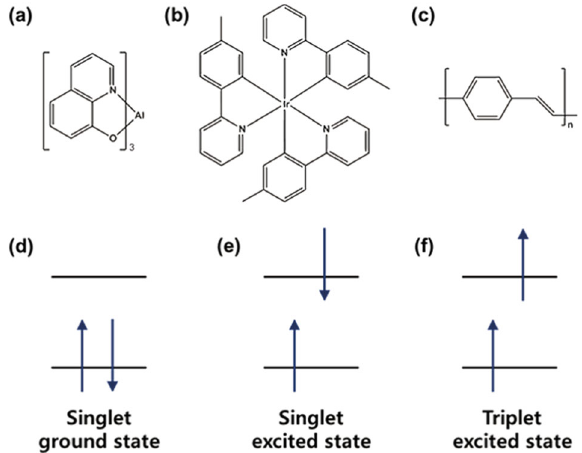
Fig. 7 Chemical structure of a Alq 3 fl uorescent dye, b Ir(mppy) 3 phosphorescent dopant, and c PPV used in OLEDs. d Illustration of electron spin in singlet ground state, e singlet excited state, and f triplet excited